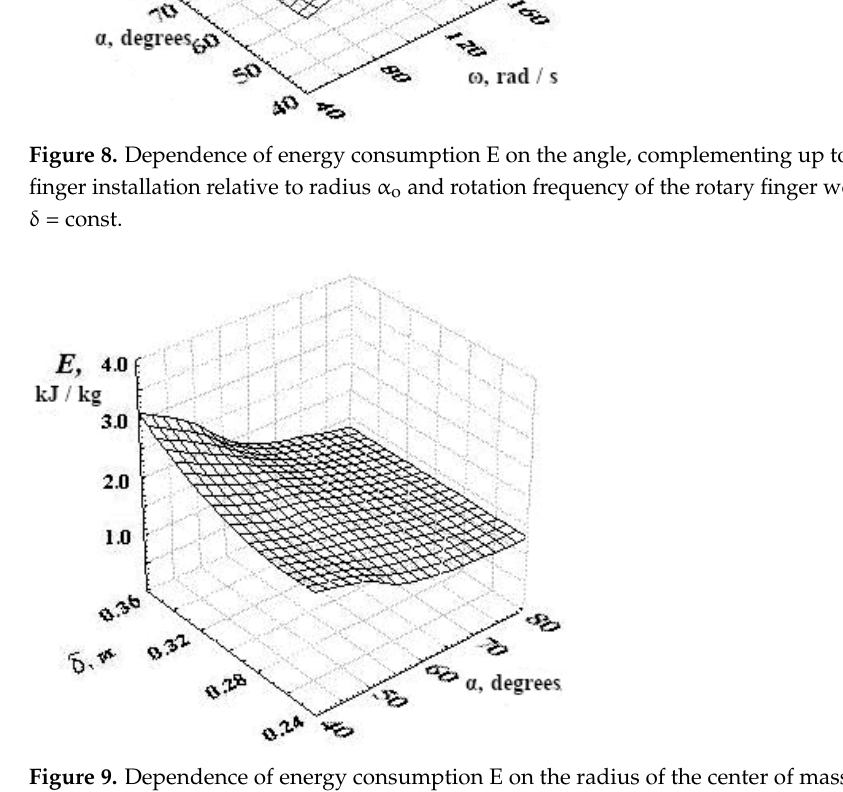
Figure 9. Dependence of energy consumption E on the radius of the center of mass δ and the an- gle, complementing up to 90° the angle of the fingers installation relative to the radius α o , at ω =